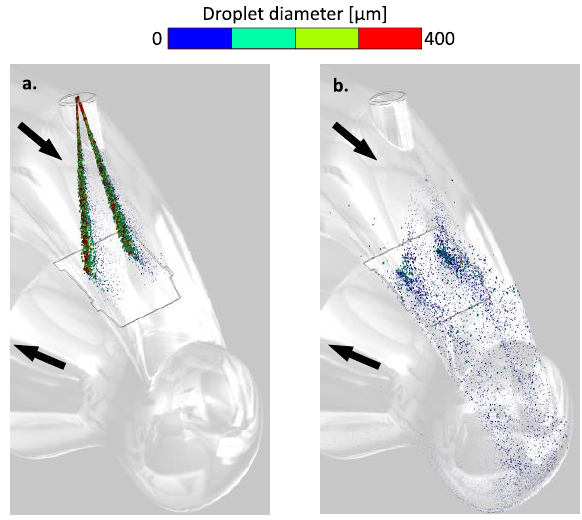
Fig. 11. Spray impingement, subcooled injection; a. 10 ms ASOI, droplet size scale: 10; b. 29 ms ASOI, droplet size scale: